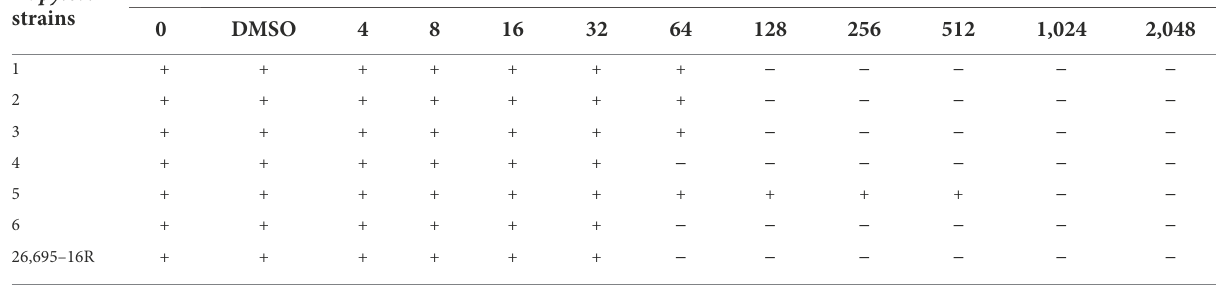
TABLE 4 MIC of JWC against H. pylori.